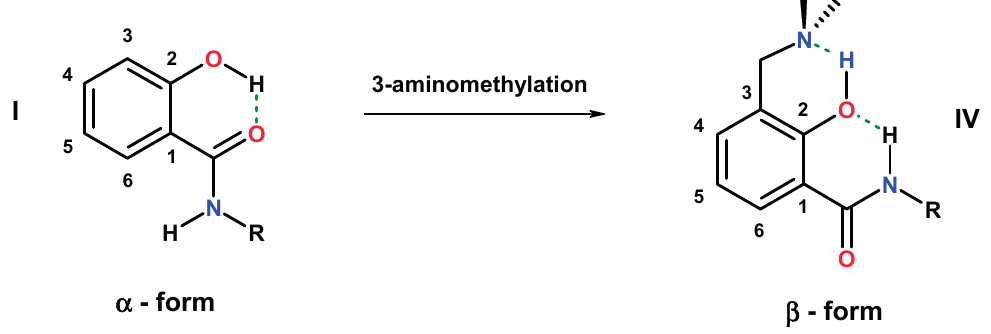
Figure 3. Competition for intramolecular hydrogen bonding in hybrids of salicylalkylamides and Mannich bases (dashed lines: hydrogen